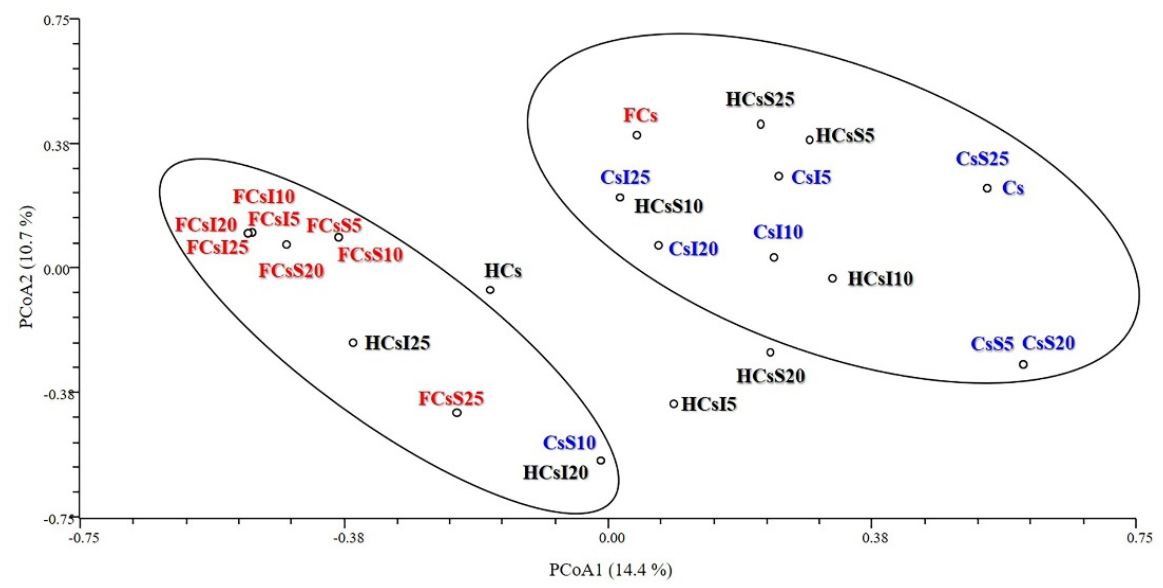
Figure 2. Principal coordinate analysis (PCoA) plot: principal coordinates 1 and 2. Cs, rearing substrate composed of 100% coffee silverskin; CsS5, CsS10, CsS20, CsS25 and CsI5, CsI10, CsI20, CsI25, rearing substrates supplemented with 5%, 10%, 20%, and 25% Schizochytrium limacinum and Isochrysis galbana, respectively; HCsS5, HCsS10, HCsS20, HCsS25 and HCsI5, HCsI10, HCsI20, HCsI25, Hermetia illucens larvae reared on the corresponding substrates; FCsS5, FCsS10, FCsS20, FCsS25 and FCsI5, FCsI10, FCsI20, FCsI25, frass collected from the H. illucens larvae reared on the corresponding substrates. Color-coding: feeding substrates (blue), H. illucens larvae (black), and frass (red).